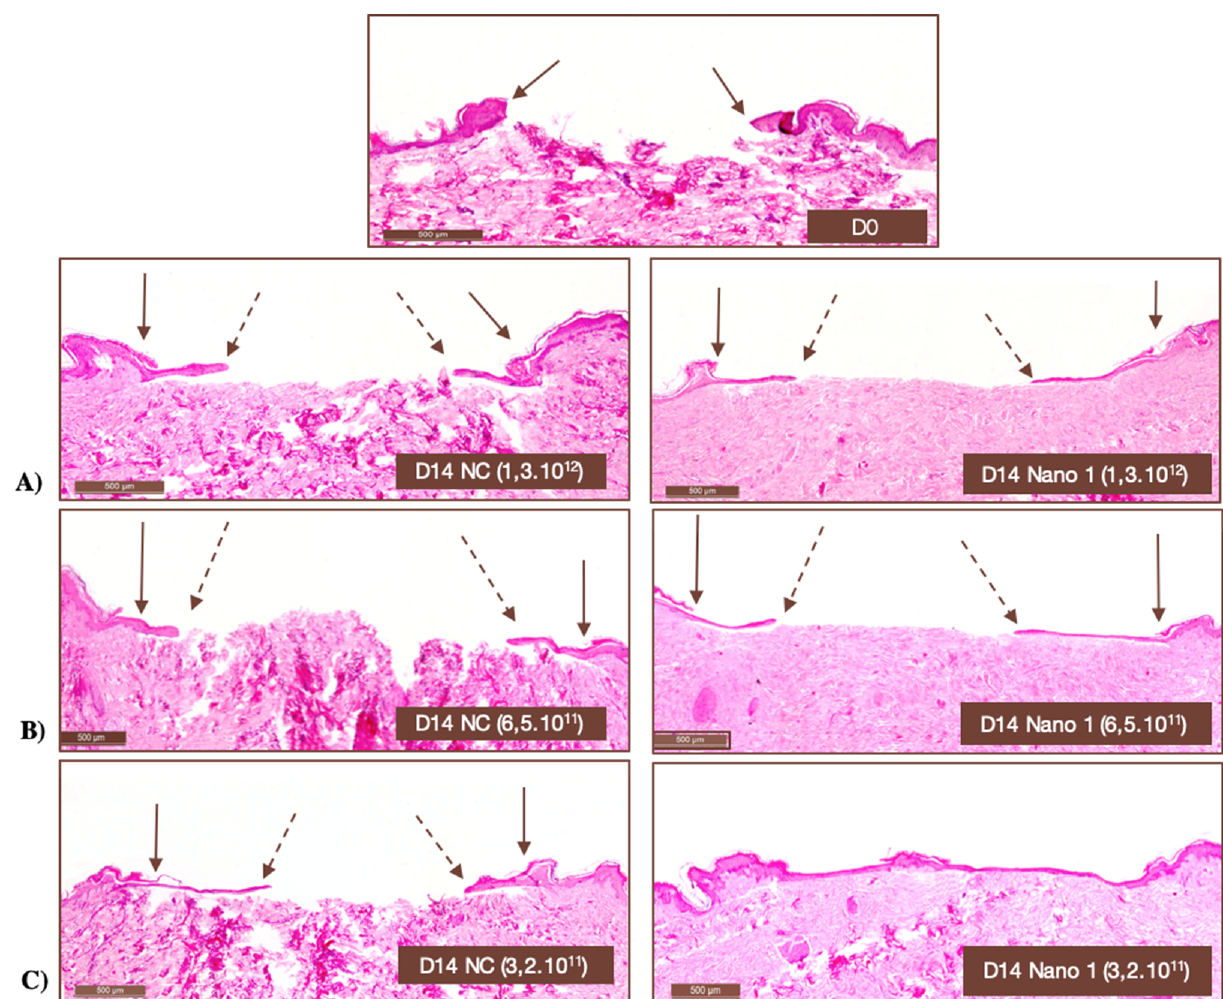
Figure 9. Histological images of human skin fragments immediately after ulcer induction (D0) and after 14 days of daily application of different numbers of NC and Nano-1 particles. ( A ) 1.3 × 10 12 particles/mL, ( B ) 6.5 × 10 11 particles/mL, and ( C ) 3.2 × 10 11 particles/mL. Hematoxylin-eosin staining. 100 × magnification. Solid arrows indicate the onset of ulceration, while dashed arrows indicate the lining of new epithelium.